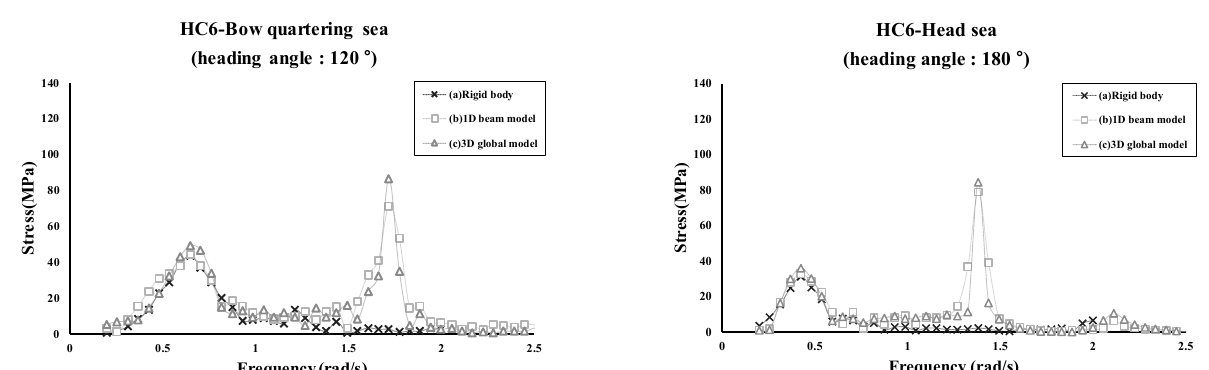
Figure 14. Stress transfer function at HC3.